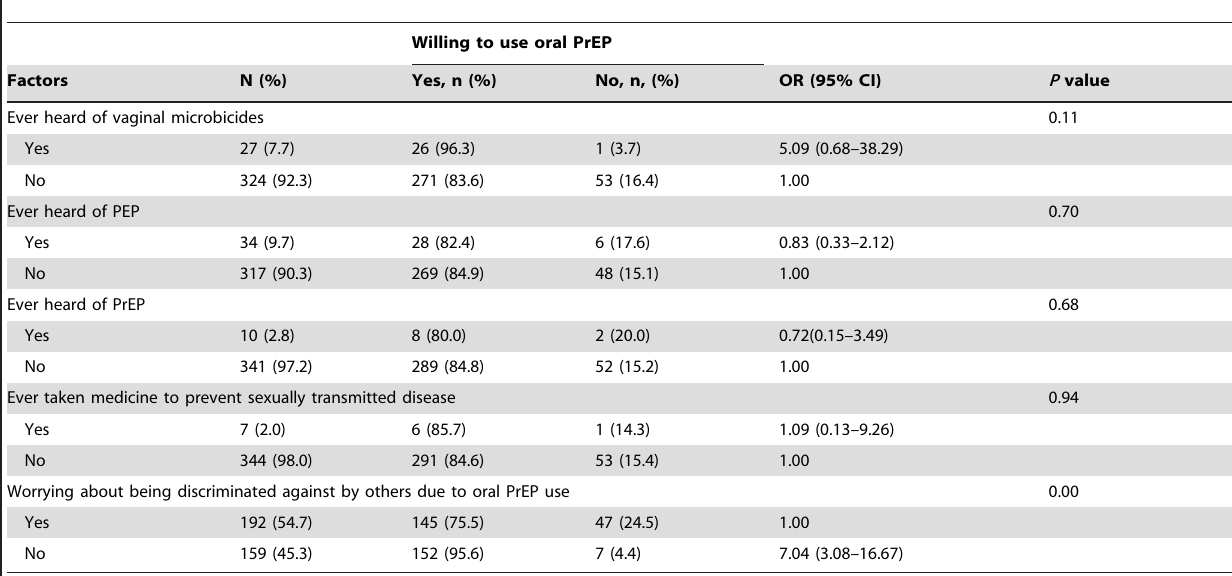
Table 4. Relationship between awareness of/use of/attitudes toward PrEP and willingness to use PrEP.